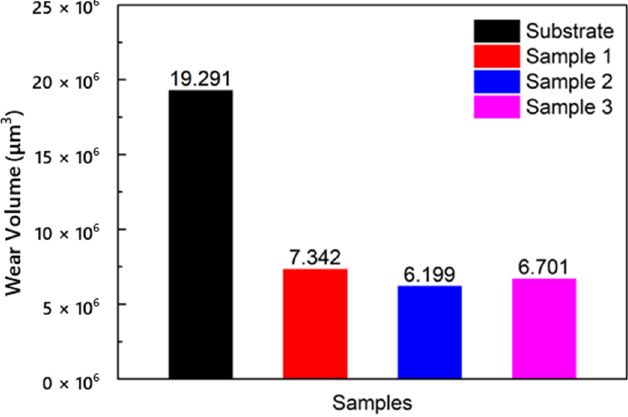
Figure 15. Volume losses of the substrate and cermet coatings at various laser powers.